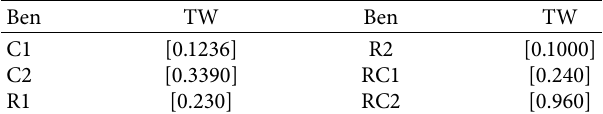
Table 5: Time windows of the depots.